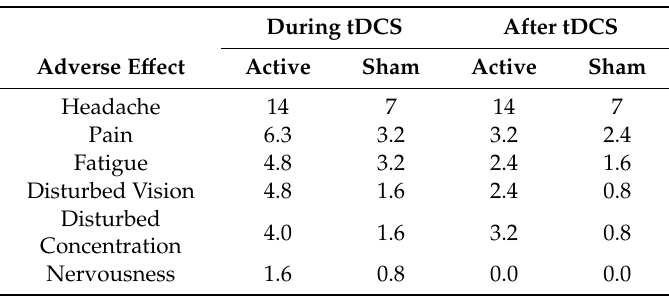
Table 2. Percentage of patients reporting adverse e ff ects of transcranial direct current stimulation (tDCS) during and directly after termination of stimulation blocks. During tDCS After tDCS Adverse E ff ect Active Sham